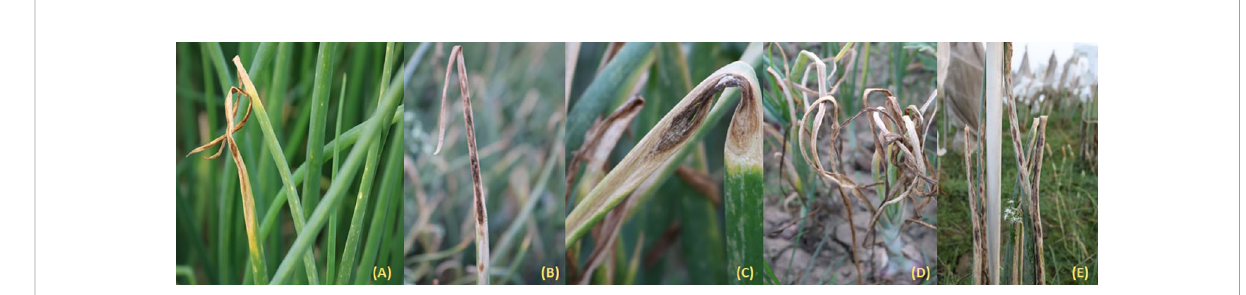
FIGURE 1 Symptoms of Stemphylium leaf blight. (A) Initial brown oval lesions formed on the leaf tip. (B) Lesions and their progression toward center. (C) Brown oval lesions formed in the center. (D) Complete drying of leaves. (E) Severe infection and breaking of fl oral